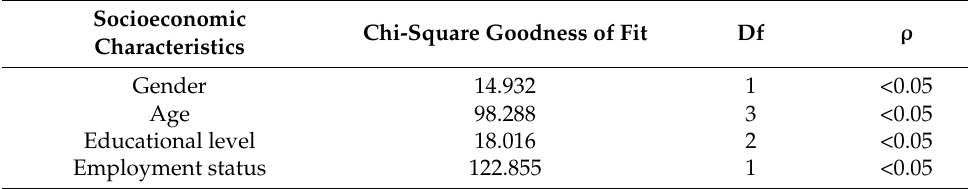
Table 4. Chi-square goodness of fit test for shared e-scooter users in Braga (N = 78).